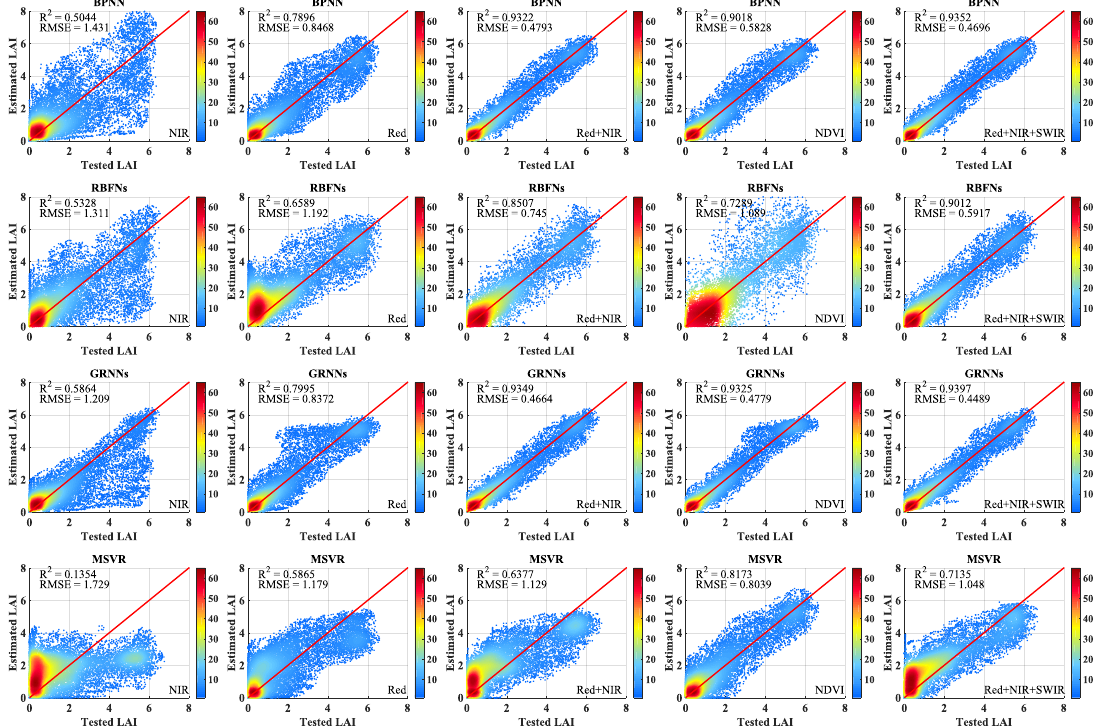
Figure 4. Scatter density plots of four machine learning methods between the testing LAI values and the LAI values retrieved from MODIS surface reflectance data in different band combinations and NDVI values.